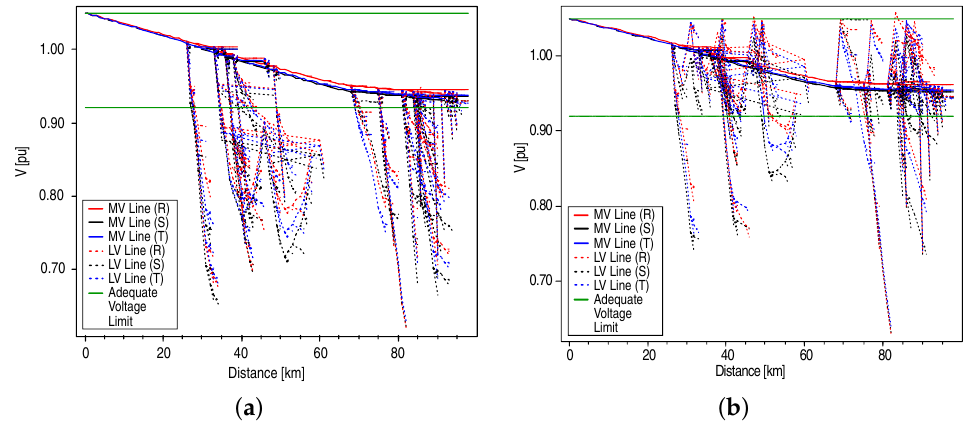
Figure 27. Result of the optimization of the variables qtd , pos , and pot without bars restriction: ( a ) voltage profile before the allocations and ( b ) voltage profile after the